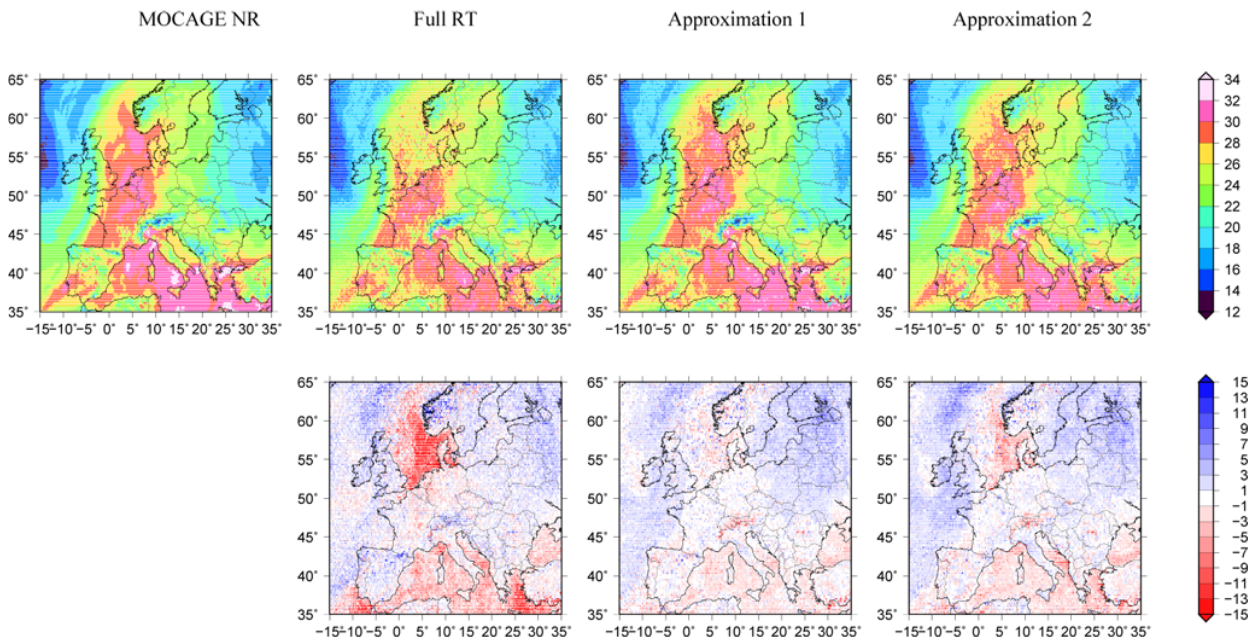
Fig. 8. Surface-6km ozone partial column over Europe, 20 August 2009 at 09:00UTC, from MOCAGE NR (left panels), full RT pseudo- observation (centre-left panels) and approximated pseudo-observations (centre-right and right panel panels) (top panels); percent differences of full RT and approximated pseudo-observations with respect to MOCAGE NR (bottom